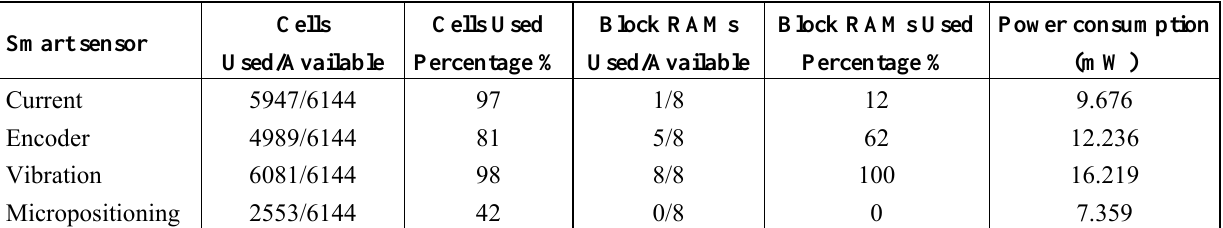
Table 2. FPGA resources utilization for each smart